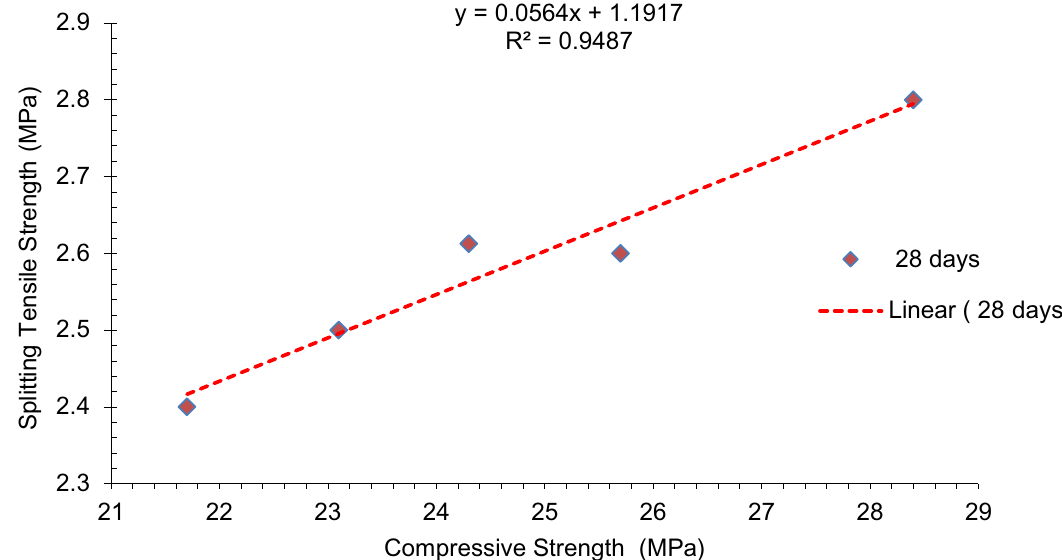
Figure 7. Co-relation between splitting tensile strength and compressive strength.